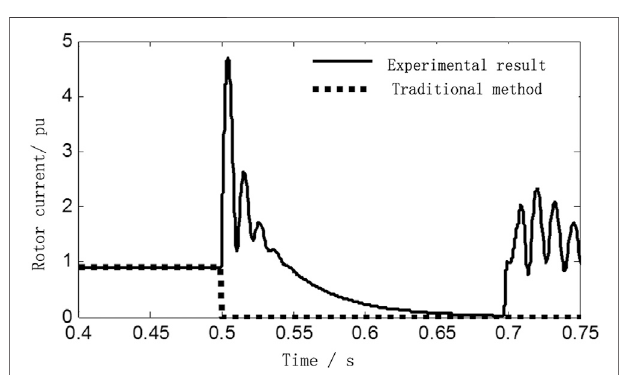
FIGURE 4 | The rotor current dynamic process of DFIG under three phase short